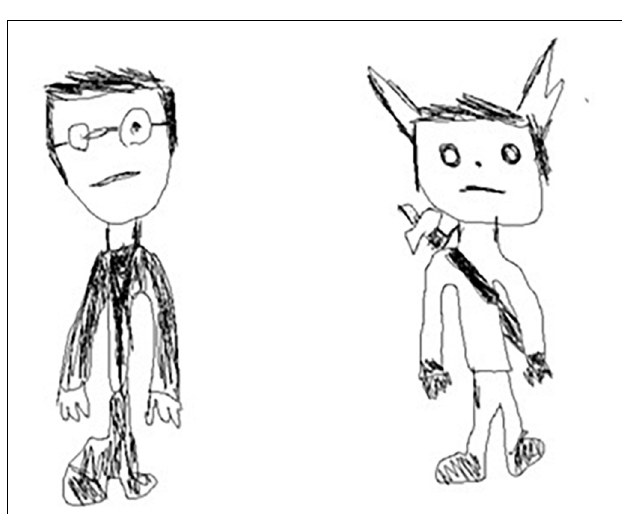
FIGURE 5 | Example of modifications operated on the form of the whole and of cross-conceptual categories insertion in finger drawing on tablet at 6th grade: compared to the unoriginal drawing (on the left), the whole original drawing (on the right) was differently shaped and included cross-category insertion such that the man was represented as a